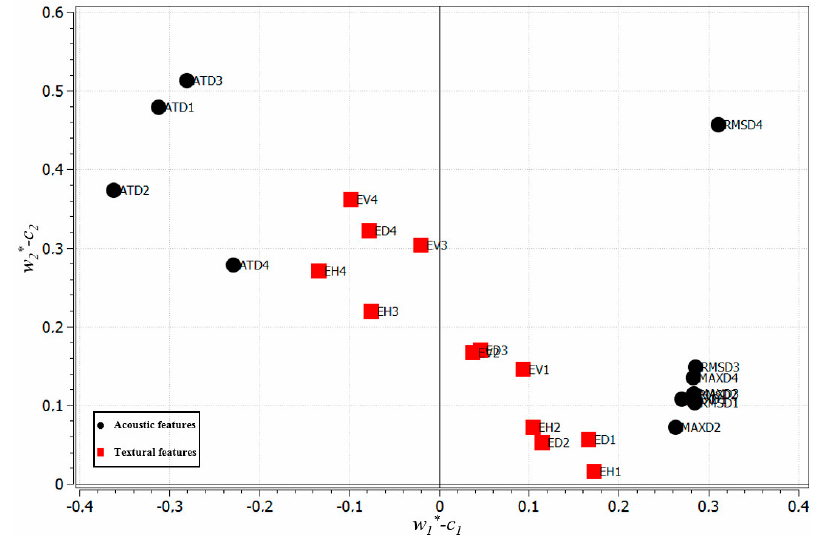
Figure 8. Loadings bi-plot ( w 2* - c 1 – w 2* - c 2 ) of the PLS model between acoustic attenuation signals and X-ray image textural features. The features are identified by their names and by the scale at which they were calculated (1–4).